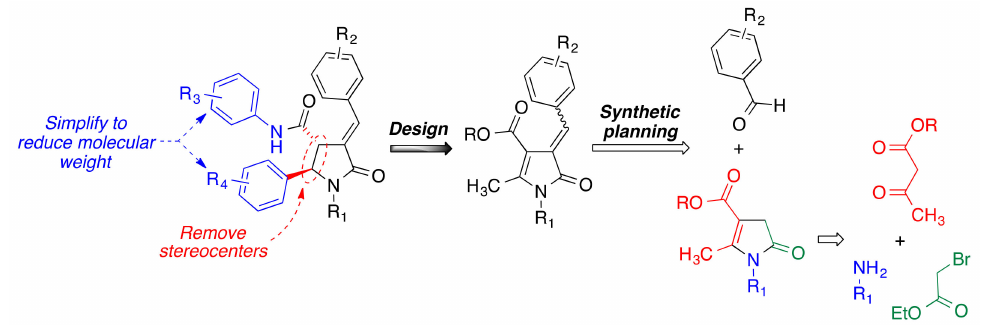
Figure 2. Compound design and synthetic planning used in this